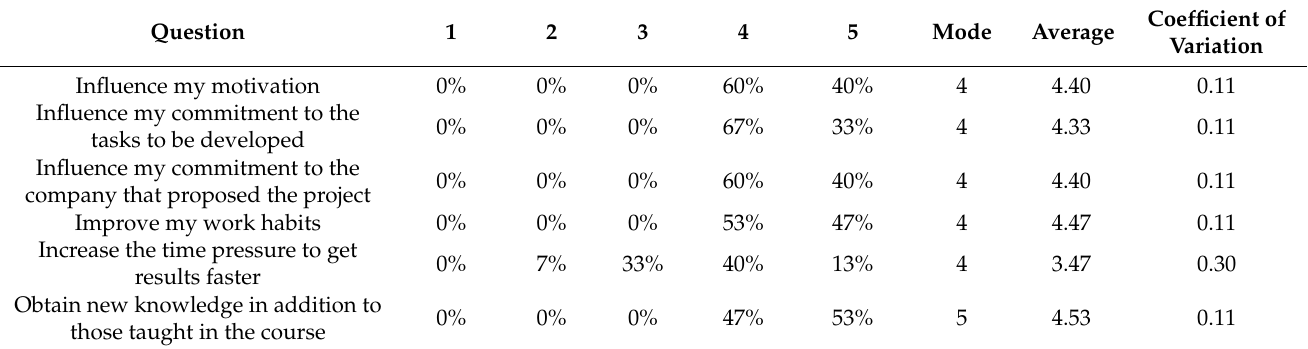
Table 4. Involvement of an external company vs. student motivation and commitment.